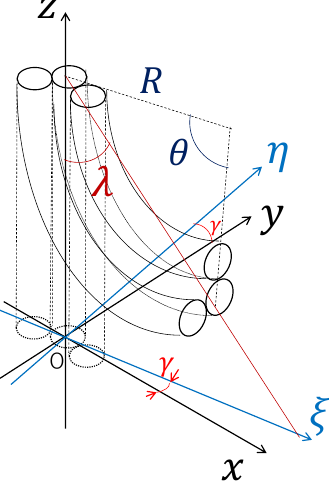
Figure 4. The model for